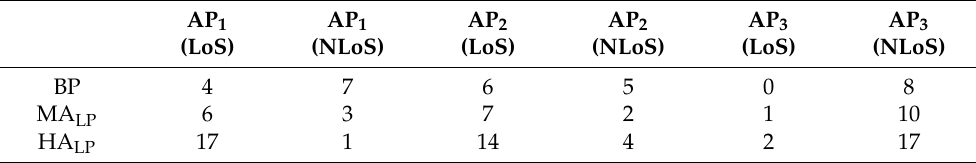
Table 3. HA LP , MA LP , and BP in the LoS/NLoS scenario with three